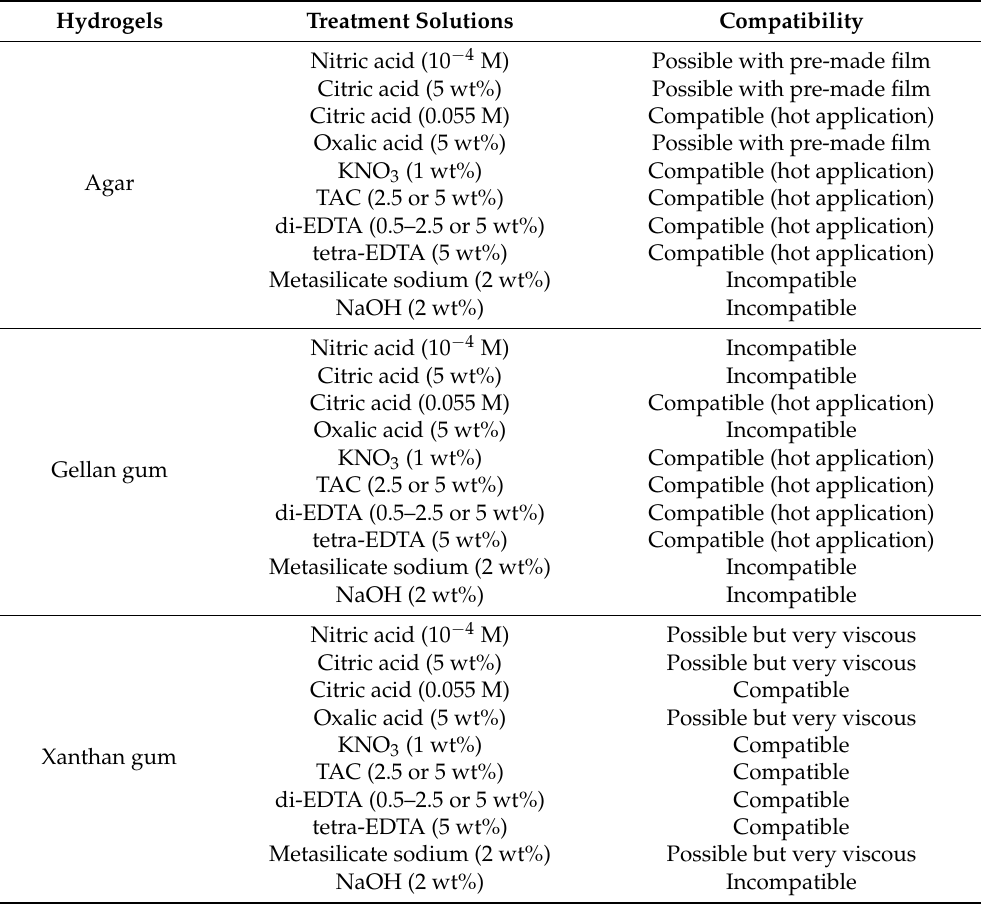
Table 1. Compatibility of treatment solutions with physical polysaccharide-based hydrogels (agar, gellan gum and xanthan